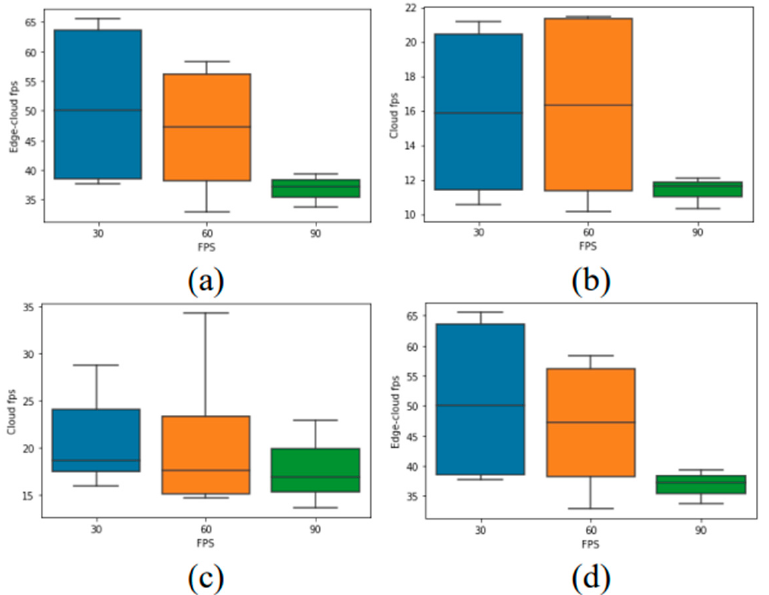
Figure 5. Box plot of the processing speed achieved on the ( a ) edge, ( b ) cloud 1, ( c ) cloud 2, and ( d ) edge–cloud for each input video FPS.